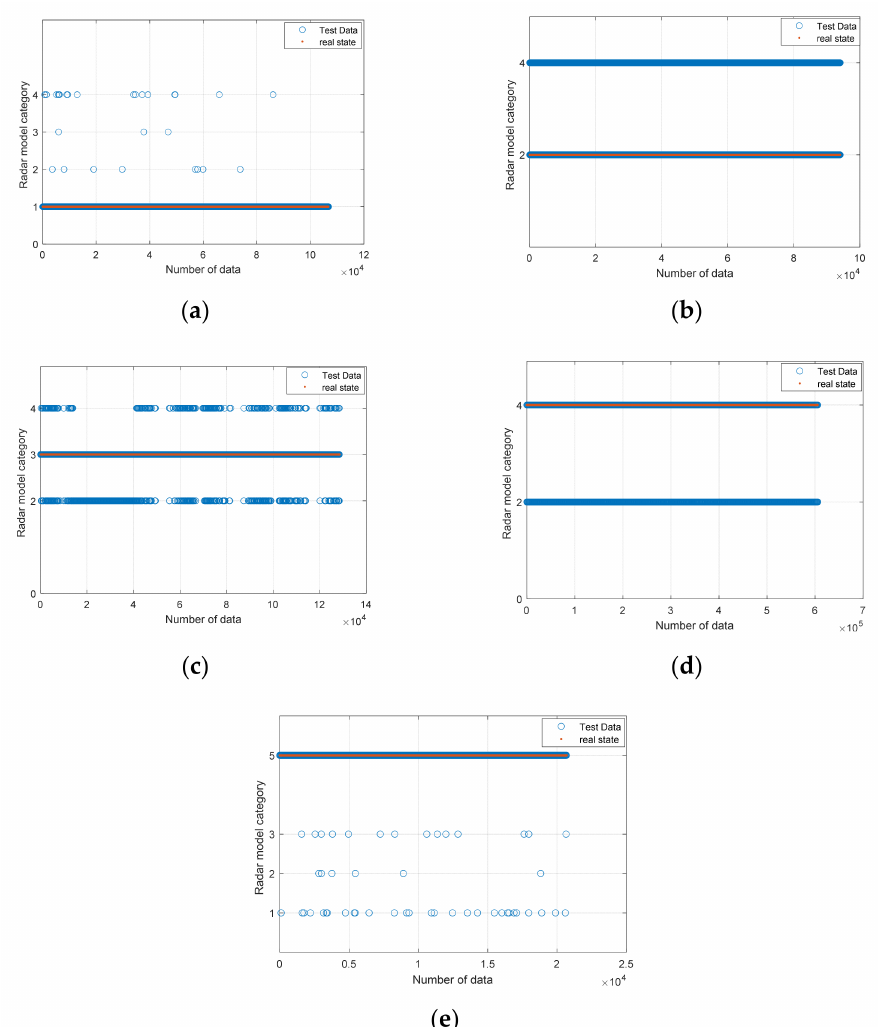
Figure 7. IFS decision recognition results. ( a ) Radar 1 recognition results; ( b ) Radar 2 recog- nition results; ( c ) Radar 3 recognition results; ( d ) Radar 4 recognition results; and ( e ) Radar 5 recognition results.